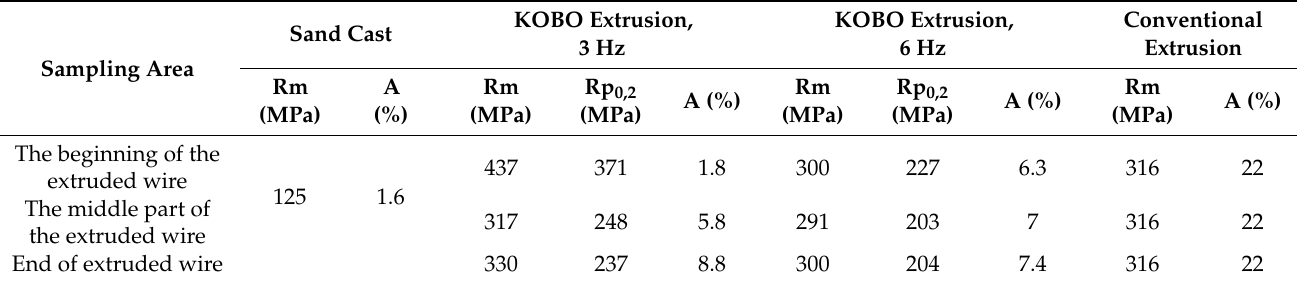
Table 3. Tensile strength (Rm), yield point (Rp 0.2 ) and elongation (A) of the sand casting made of AZ91 (MgAl9Zn1) magnesium alloy and after the extrusion process by the conventional method ( λ = 45) and the KOBO method (die rotation frequency f = 3 and 6 Hz, λ = 44.4). Measurements performed at ambient temperature. The measurement uncertainty did not exceed